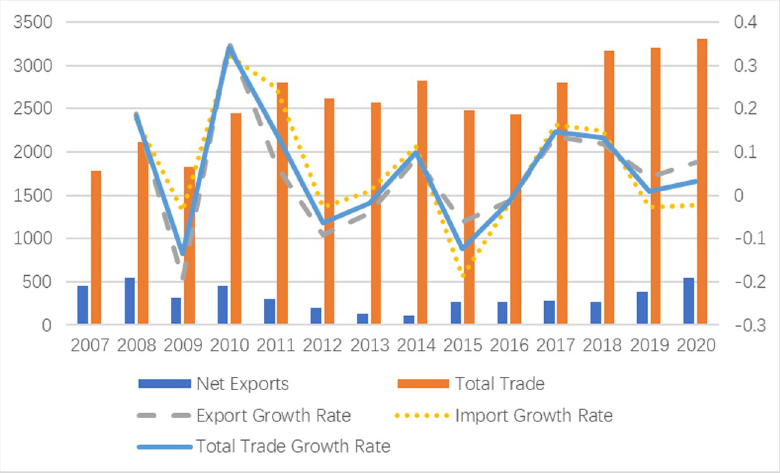
Fig 1. Trend of China’s import and export to EU equipment manufacturing industry from 2007 to